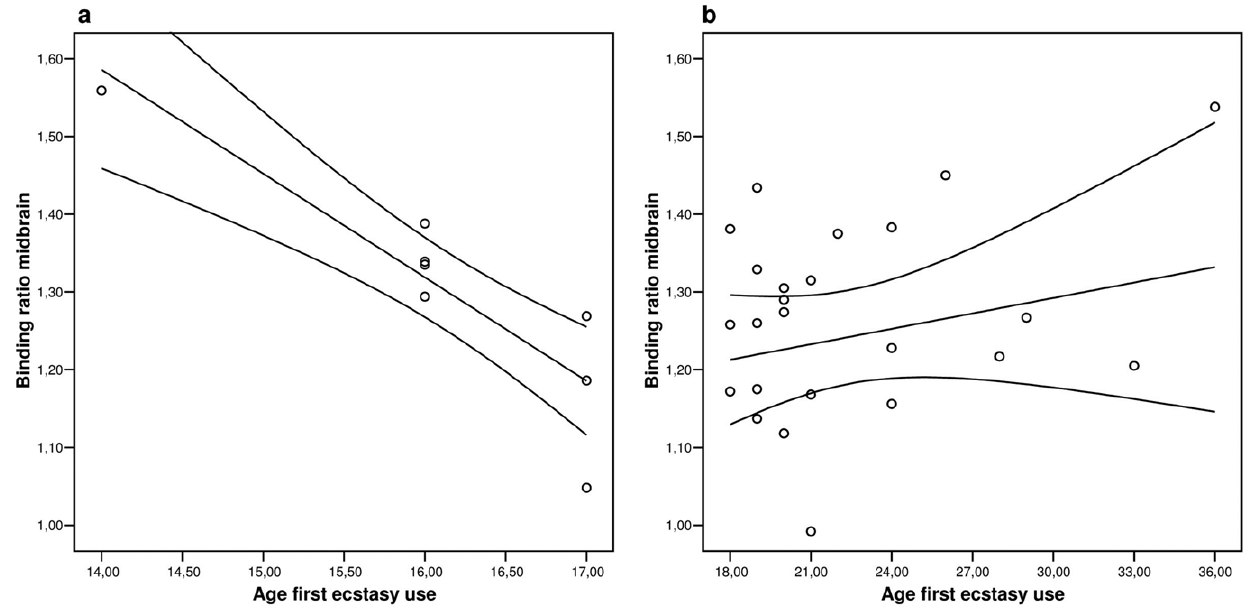
Figure 1. Early age of ecstasy use predicts higher SERT density in the developing brain. Midbrain SERT binding ratio plotted against age- at-first ecstasy exposure during a ) brain development (first ecstasy use before 18 years; r 2 =0.789, r= 2 0.888, p=0.003) and in b) in the mature brain (first ecstasy use 18 years or older; r 2 =0.032, r=0.179, p=0.392). 95% confidence limits are included with the regression line.